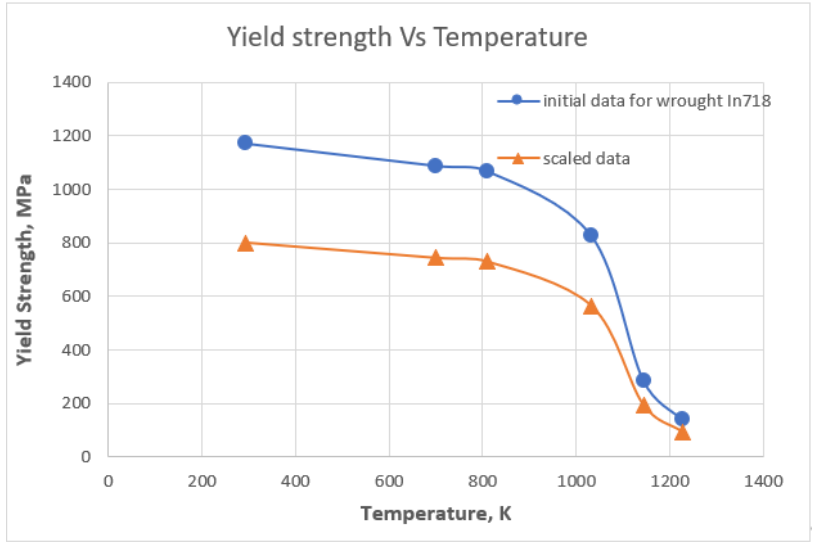
Figure 3. Initial and scaled temperature-dependent yield